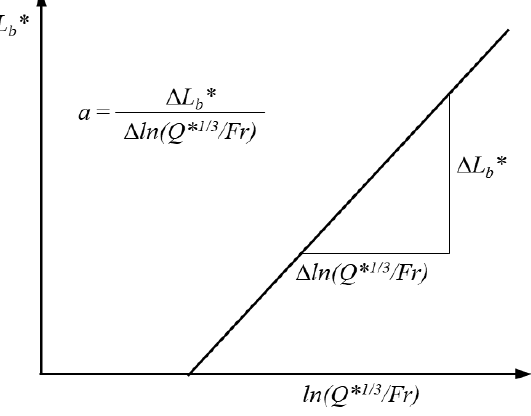
Figure 14. Linear relationship between ln(Q* 1 / 3 / Fr) and L b * .